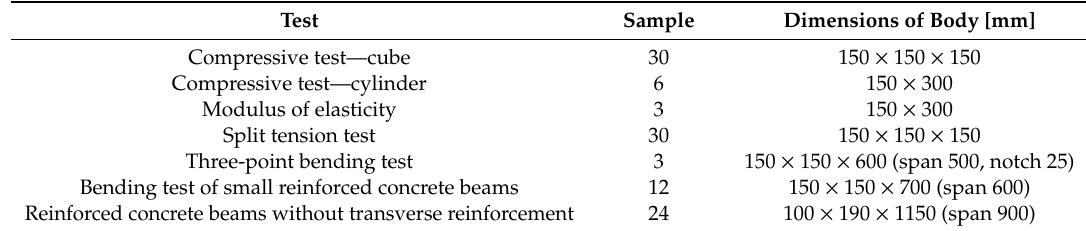
Table 3. Test setup program.